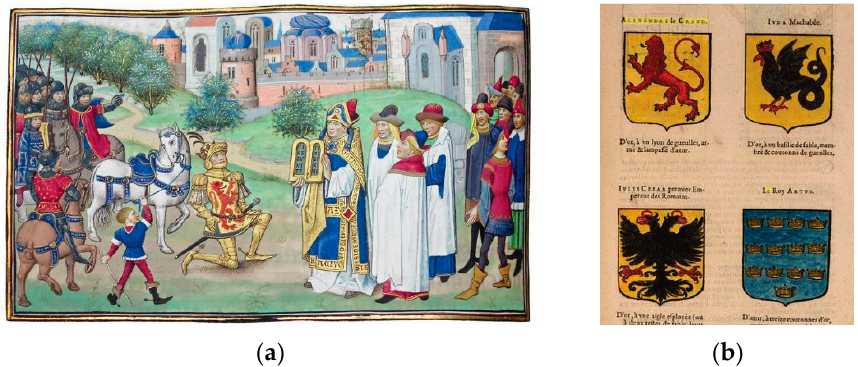
Figure 6. ( a ) Alexander, Les Faicts et les conquestes d’Alexandre le Grand ; ( b ) Arms of the nine worthies, Blason des Armoiries .